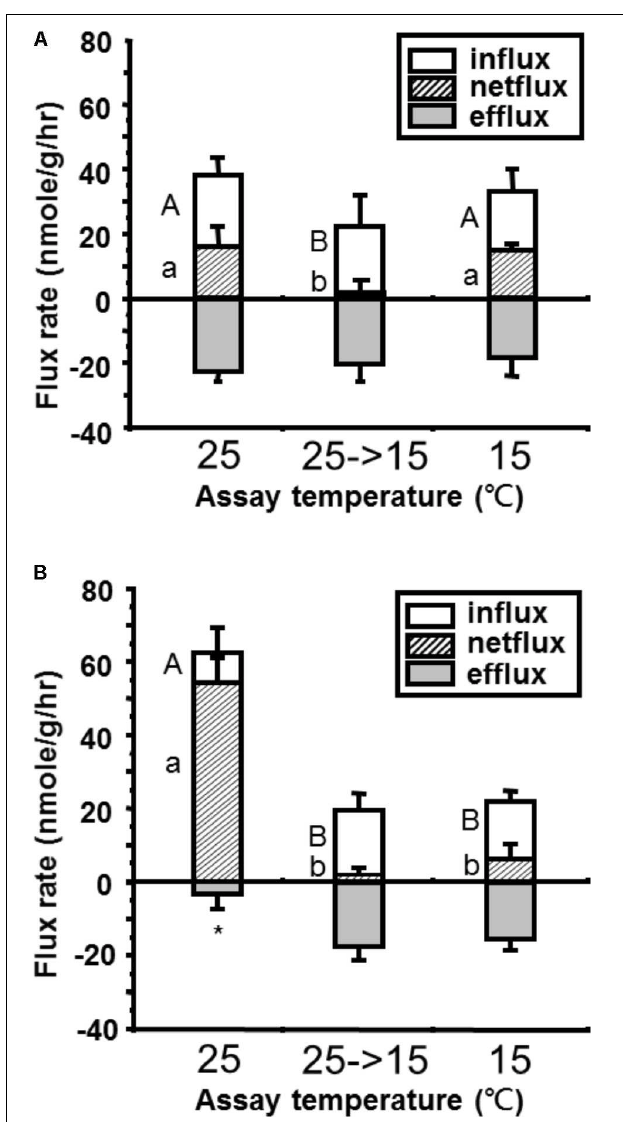
FIGURE 1 | Comparison of whole-body Ca 2 + flux rates in (A) goldfish and (B) tilapia after short term (25 ◦ C → 15 ◦ C) or long-term (15 ◦ C) cold acclimation. One-way ANOVA, Tukey’s multiple-comparison. AB p < 0.05 compared to short- and long-term acclimation Ca 2 + influx, ab p < 0.05 compared to short- and long-term Ca 2 + net flux and ∗ p < 0.05 compared to short- and long-term Ca 2 + efflux ( n = 8) are significant different.